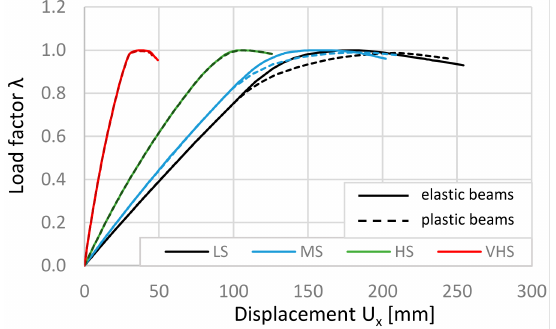
Figure 6. Comparison of the behaviour of the frames considering elastic and elastoplastic